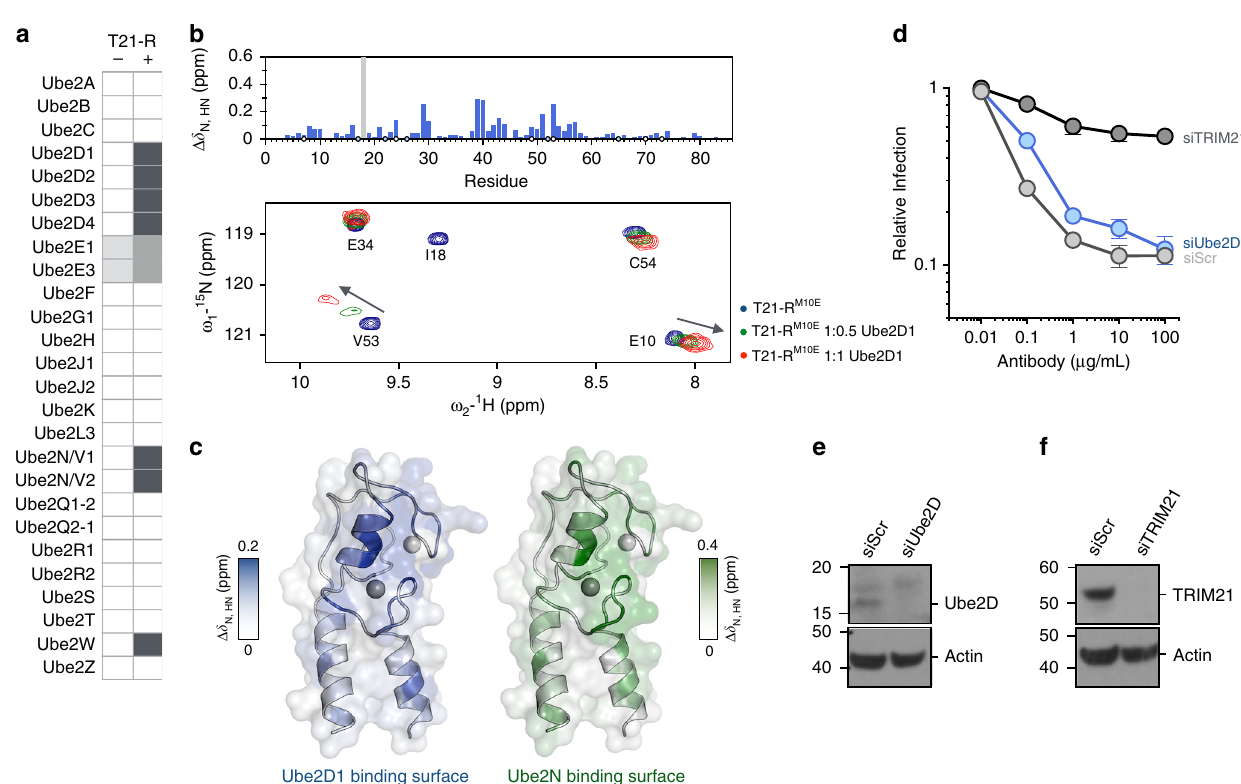
Fig. 1 TRIM21 binds and catalyzes ubiquitination with physiologically redundant E2s. a In vitro E2 enzyme screen (no catalysis, white; catalysis, grey). Full blots are given in Supplementary Fig. 1. b A part of 15 N-HSQC spectra of T21-R M10E in absence (blue) and presence of 0.5 (green) or 1 (red) molar equivalents of Ube2D1. Histogram of the chemical shift perturbations is shown against the primary structure. Blue circles indicate proline residues, white circles missing assignments. The gray bar in the histogram represents intermediate exchange of the amide of I18, as inferred from the disappearance of the I18 signal upon addition of Ube2D1. c The amide chemical shift perturbation upon E2 titration is mapped onto the T21-R structure in blue for the Ube2D1 titration (shown in Fig. 1b) and green for the Ube2N titration (shown in Supplementary Fig. 3). d Antibody (9C12)-dependent adenovirus 5 (Adv5) neutralization in HeLa cells stably transduced with small interfering RNA (siRNA) targeted against Ube2D or TRIM21. The data represent the mean ± s.e.m. from three independent experiments and normalized to virus only. Immunoblots of siRNA-mediated protein depletion of e Ube2D and f TRIM21. SiScr, scramble control siRNA. Source data are provided as a Source Data fi